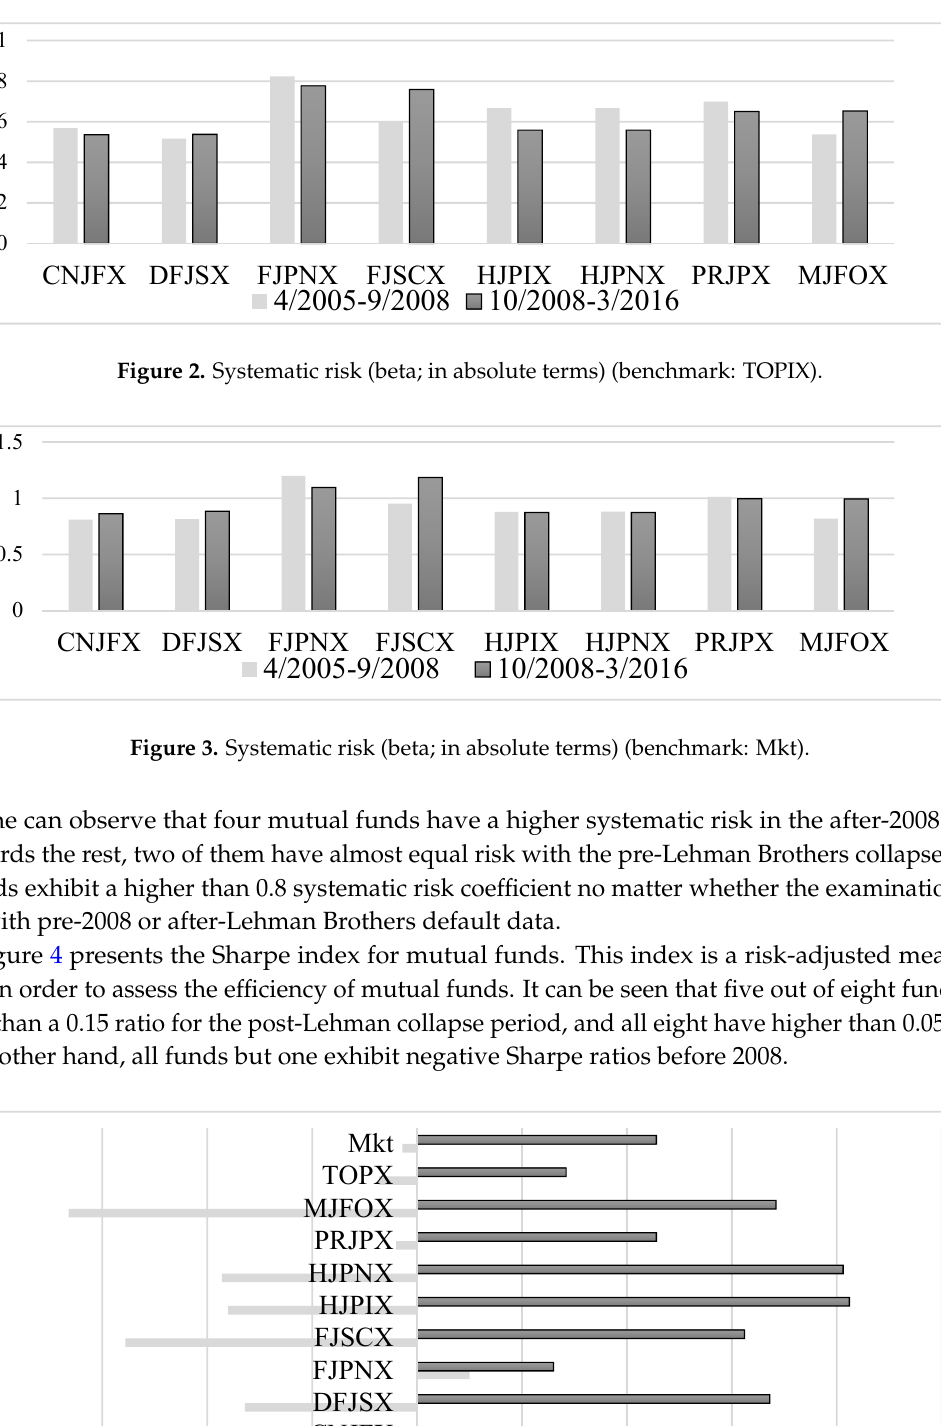
Figure 2 . Systematic risk (beta; in absolute terms) (benchmark: TOPIX).